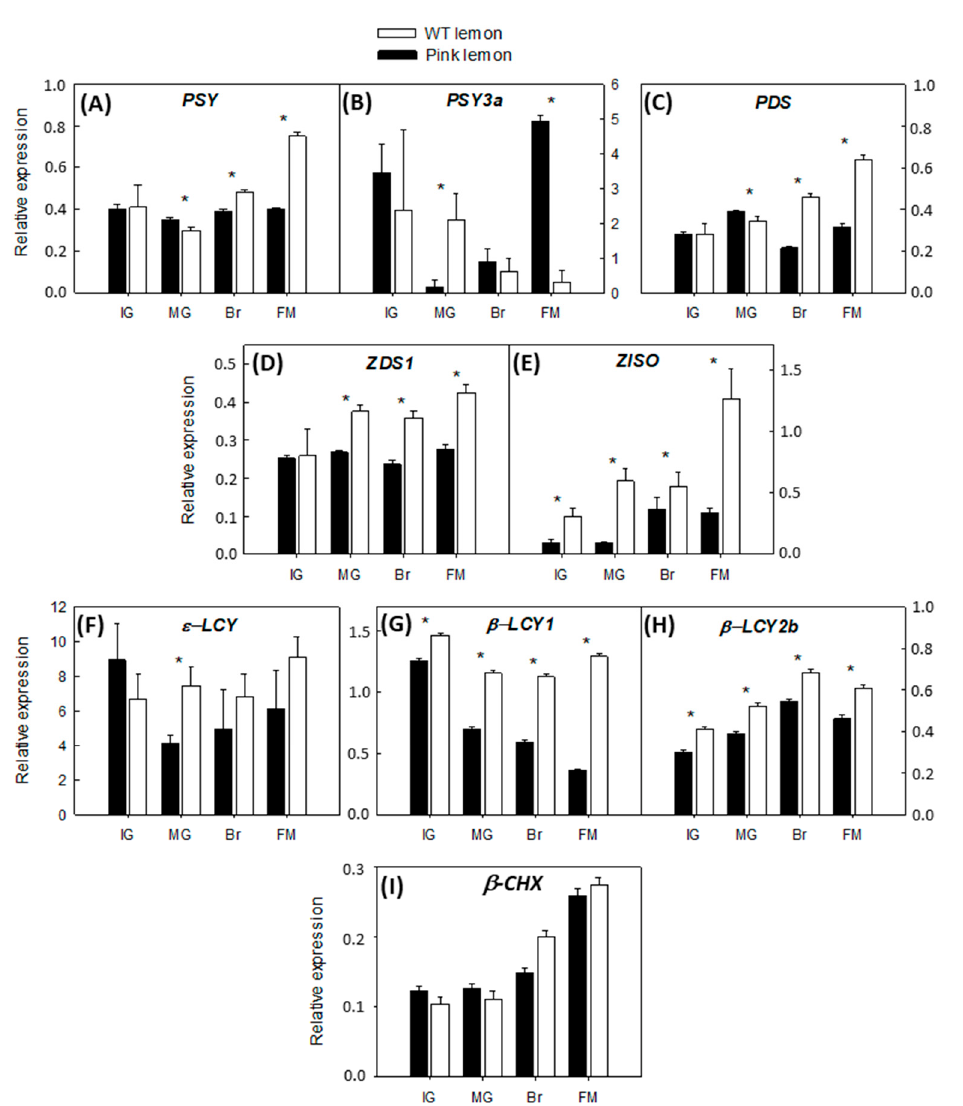
Figure 4. Changes in the expression of genes involved in carotenoids biosynthesis: PSY , phytoene synthase ( A ); PSY3a , phytoene synthase 3a ( B ); PDS , phytoene desaturase ( C ); ZDS1 , Ƶ -carotene -carotene desaturase 1 ( D ); ZISO , Ƶ -carotene isomerase ( E ); ε -LCY , ε -cyclase ( F ); β -LCY1 , β -lycopene cyclase 1 ( G ); β -LCY2b , β -lycopene cyclase 2b ( H ); β -CHX , β -carotene hydroxylase ( I ), in the pulp of PL and WT lemon fruit at four developmental stages: IG (immature green), MG (mature green), BR (breaker), FM (fully mature). Asterisks indicate significant differences between genotypes for each developmental stage ( p < 0.01) by one-way ANOVA ( p < 0.01).